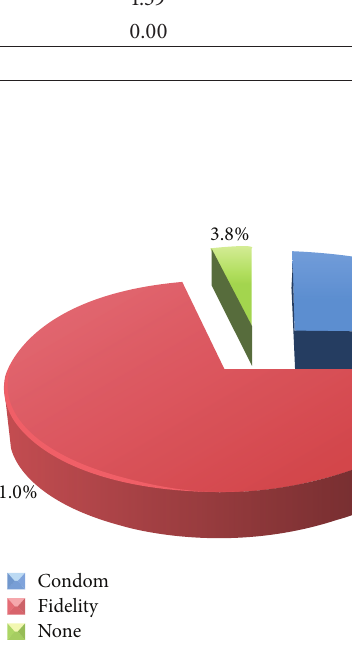
Figure 1: HIV prevention measures practiced by the